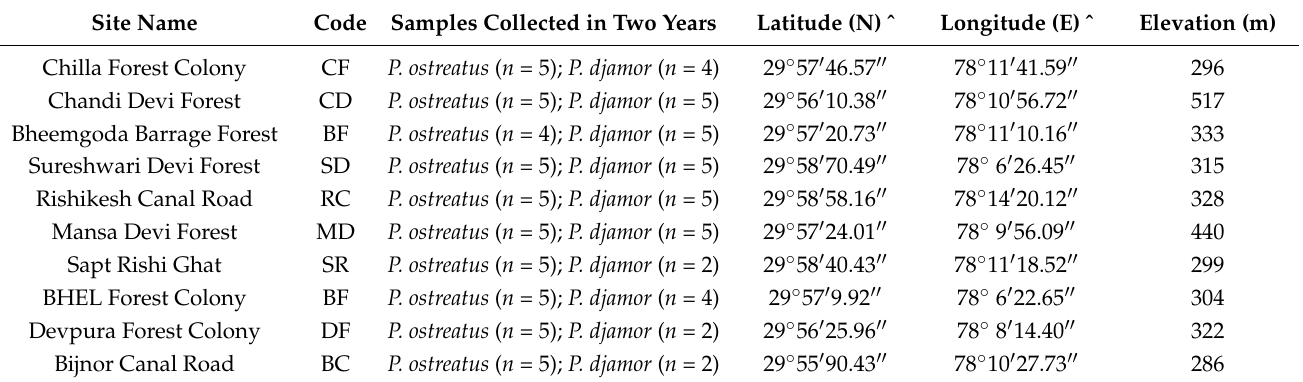
Table 1. Description of the Pleurotus spp. sampling locations in Rajaji National Park, Haridwar, India.